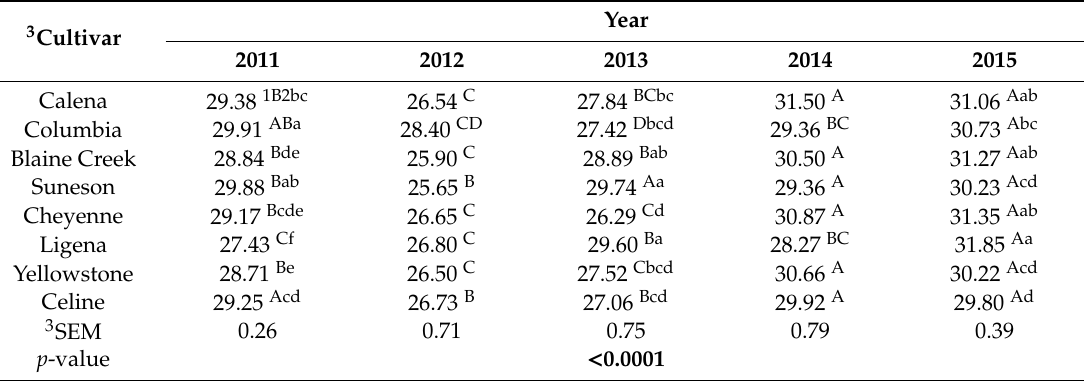
Table 7. Interaction e ff ect of the Cultivar × Year on the oil content (%) of eight C. sativa cultivars grown during the spring growing season of 2011 to 2015 in Reno, Nevada, USA.